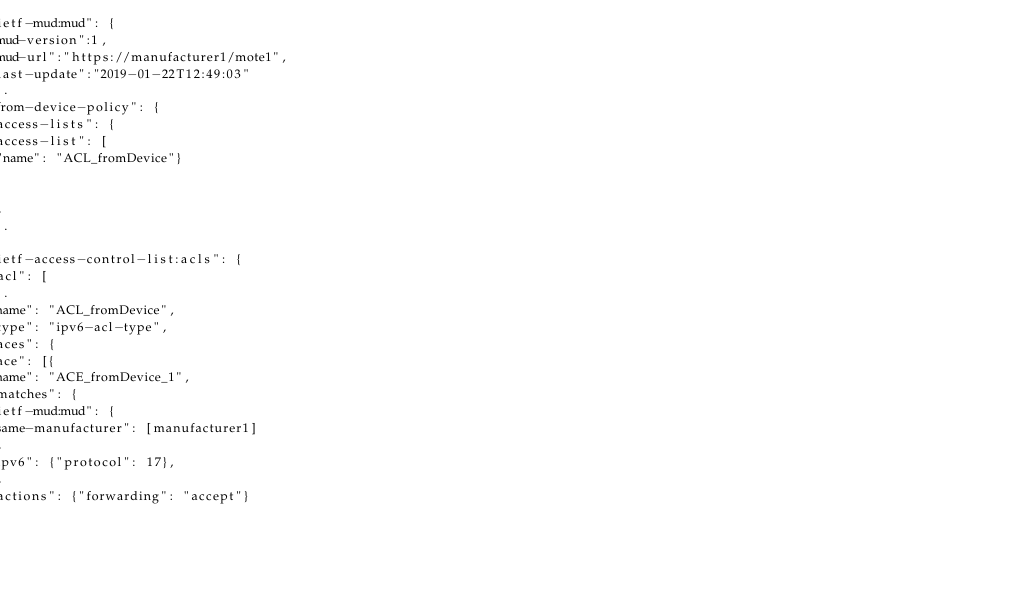
Figure 5. Integrating MUD-enhanced bootstrapping with digital twins. Listing 1: Extract from the MUD